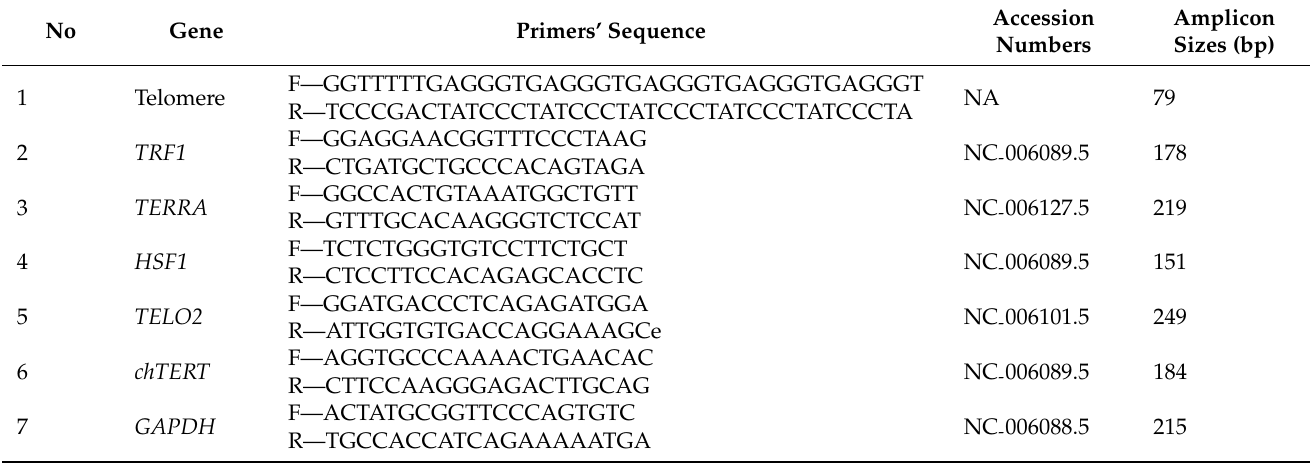
Table 2. Primer sequences for telomere and telomere regulatory genes in